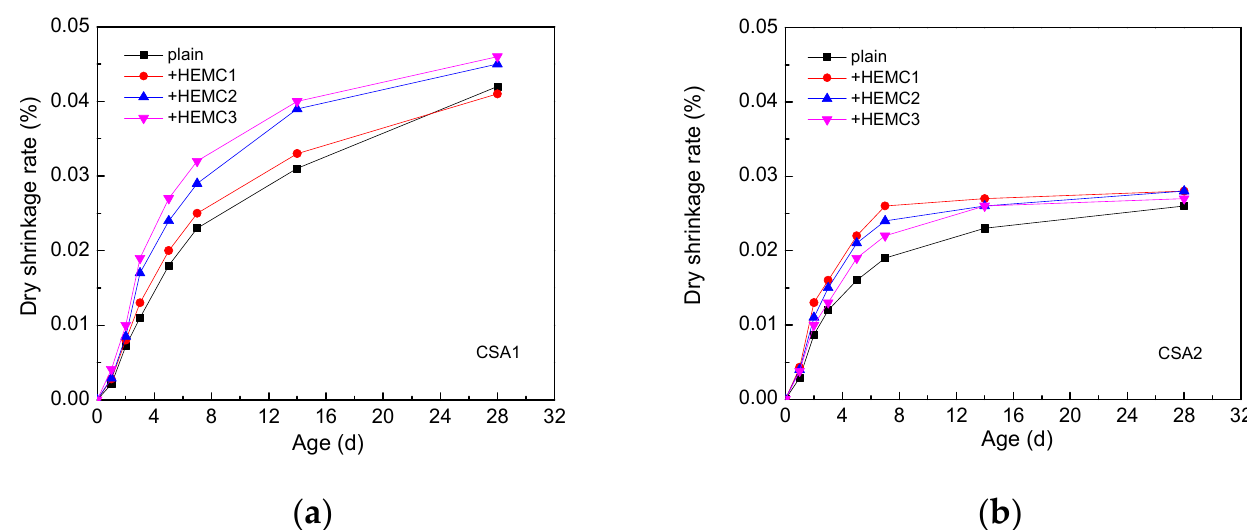
Figure 6. The dry shrinkage rate of CSA cement mortars with and without HEMCs within 28 days: ( a ) CSA1, ( b )